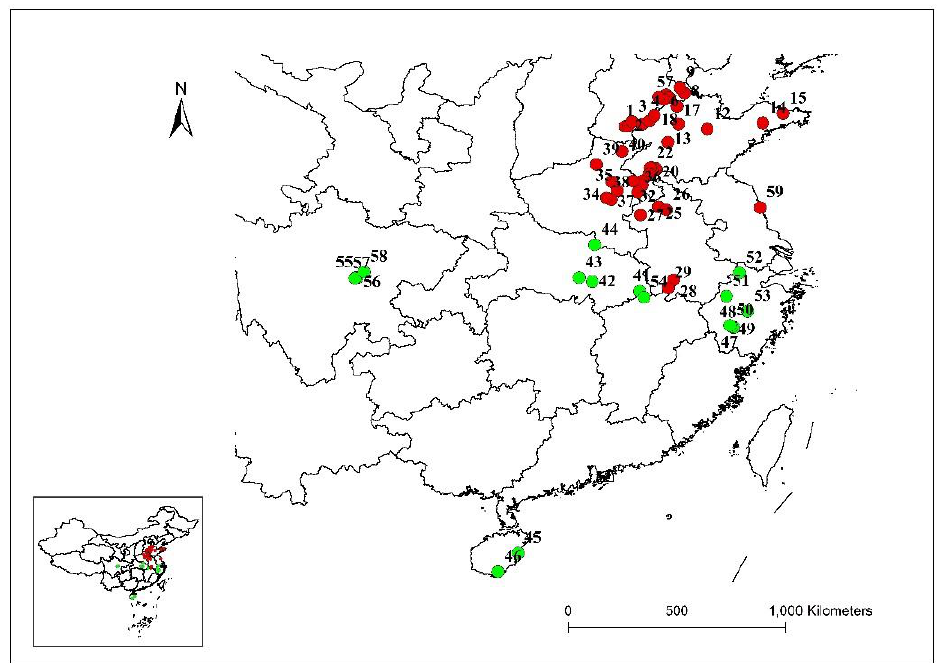
Figure 1. Distribution of the E. indica populations which collected seeds from 10 provinces in China. Each population was numbered and the color of the circle according to the results of different analysis in this research.